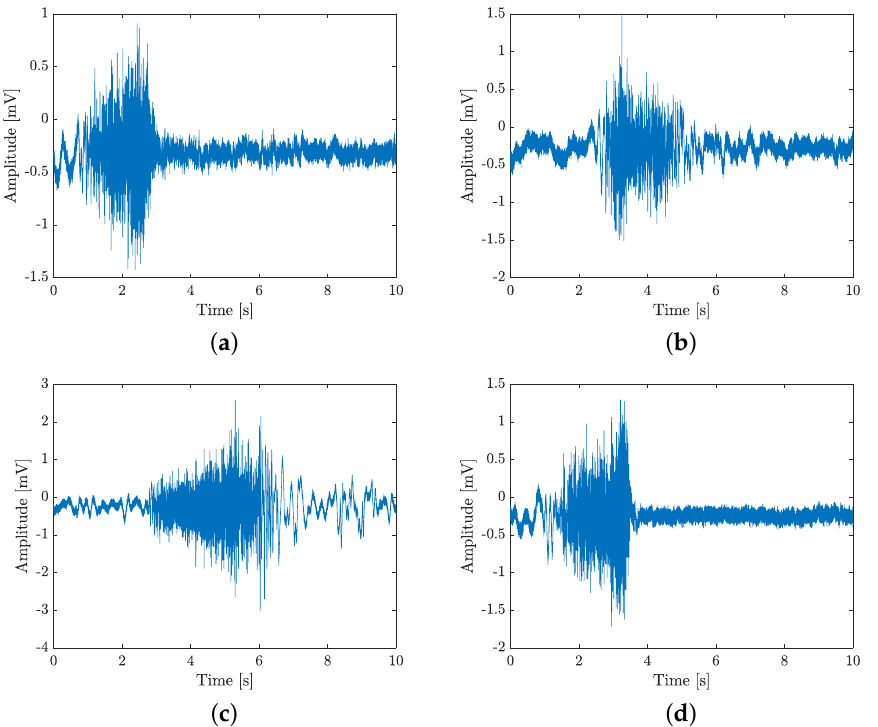
Figure 5. IF signals received by the radar for the evaluated movements of a test subject: ( a ) falling; ( b ) sitting; ( c ) walking; ( d ) falling while